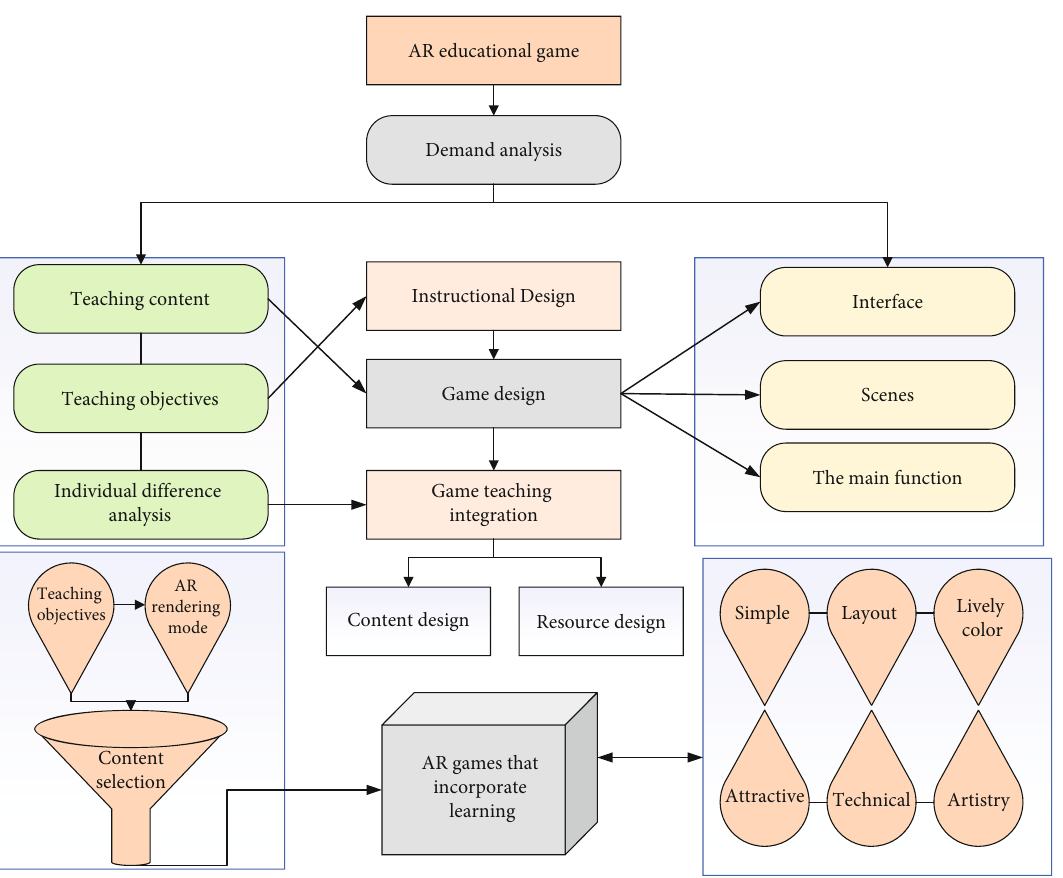
Figure 1: AR educational game design